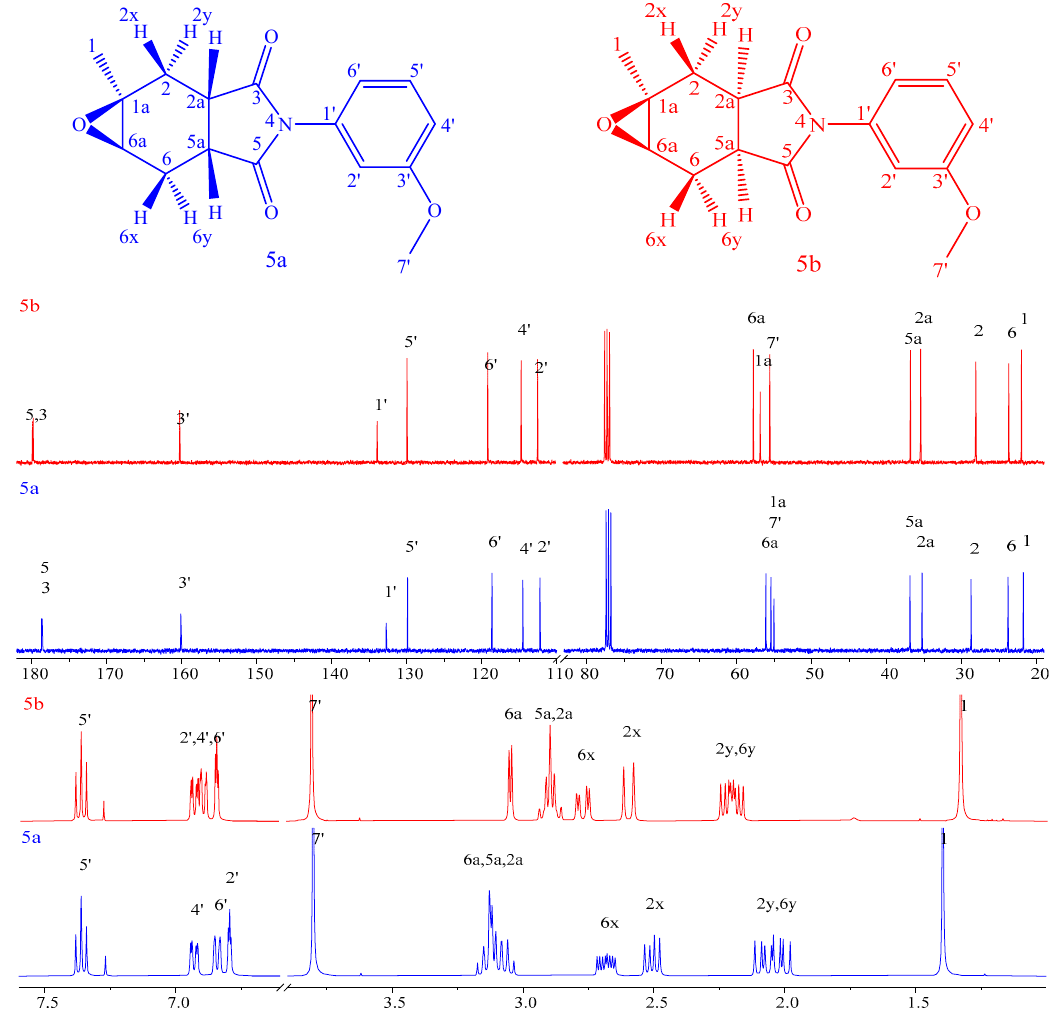
Figure 2. 13 C (100 MHz; δ TMS = 0 ppm) and 1 H (400 MHz; δ TMS = 0 ppm) NMR spectra of compounds 5a and 5b